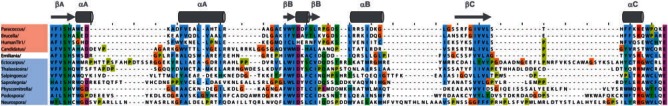
Alignment of fungal HET domains with TIR domain proteins. The TIR domains of two bacterial proteins of known structure and of the human TLR1 TIR domain (boxed in red) are aligned with the HET domains of P. anserina HET-e1 and Neurospora crassa TOL (boxed in blue) together with related sequence of diverse phylogenetic origin annotated as HET domains in Pfam. On top of the alignment, the elements of secondary structure of Brucella TcpB are shown. Sequence designations are as follows: Paracoccus, Paracoccus denitrificans, gi|500070302; Brucella, Brucella melitensis, gi|516360271; Human Tlr1, Homo sapiens, gi|194068387; Candidatus, Candidatus Accumulibacter, gi|589611804; Emiliania, Emiliania huxleyi, gi|551574256; Ectocarpus, Ectocarpus siliculosus, gi|298709304; Thalassiosira, Thalassiosira pseudonana, gi|224000455; Salpingoeca, Salpingoeca rosetta, gi|514691135, Physcomitrella, Physcomitrella patens, gi|168042266; Podospora, P. anserina, gi|3023956 (HET-e1); Neurospora, Neurospora crassa, gi|553134703 (TOL).